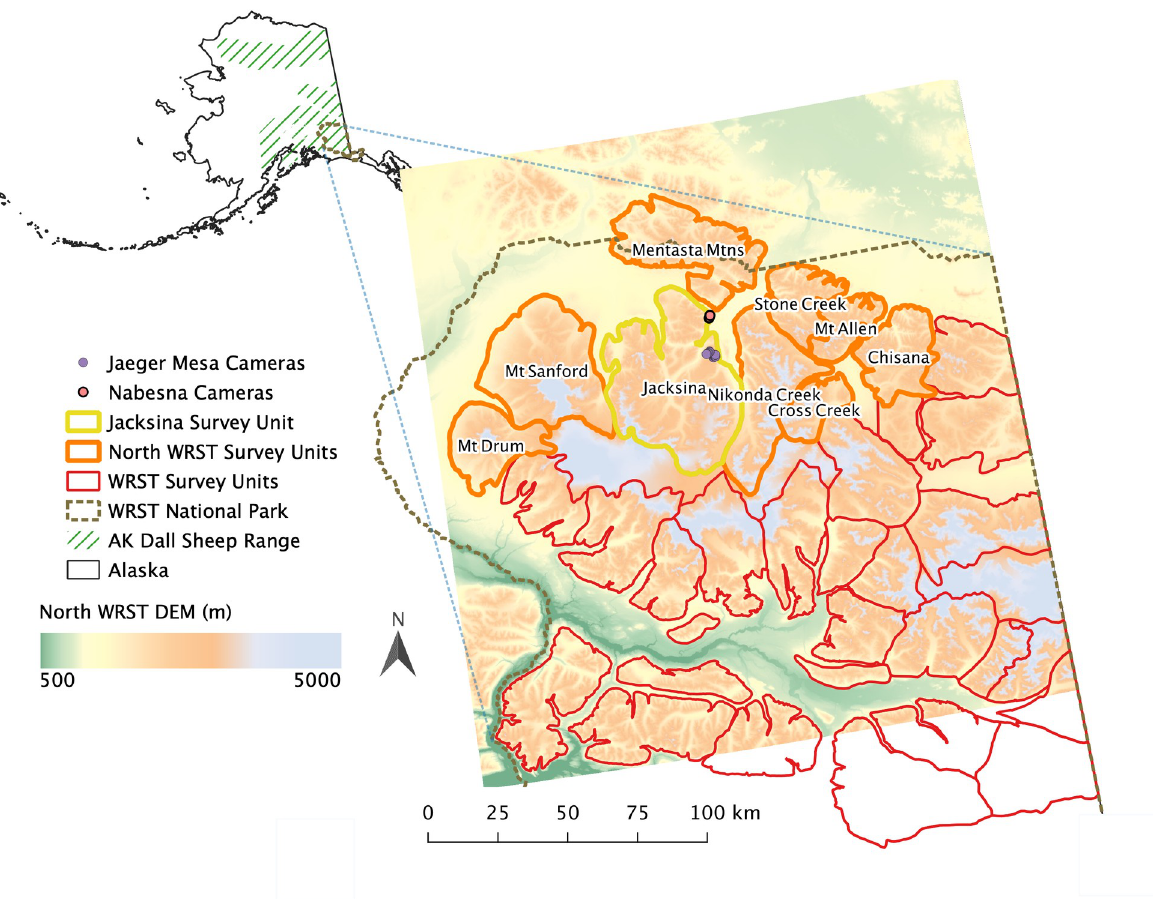
Fig 1. Map of study area located in the northern Wrangell-St. Elias National Park and Preserve (WRST; brown dashed outline) and Alaska (inset). Field-based snow surveys, including the installation of remote cameras upon Jaeger Mesa and near Nabesna, took place in the central Jacksina sheep survey unit (yellow outline) to calibrate a physically-based, spatially distributed snow evolution model. With the calibrated model we simulated daily snow conditions for high-elevation Dall’s sheep terrain within the Jacksina survey unit domain from 1980 to 2017. A remote sensing analysis determined that the mean snow disappearance date (SDD) in 8 other survey units (outlined orange) was more similar to that of Jacksina compared to that of other units in the WRST (outlined red). We hence used observations of summer lamb-to-ewe ratios from Jacksina and these 8 nearby units to compare to model-derived metrics of seasonal snow conditions. GIS data for sheep survey units and WRST park boundary were sourced from [57, 58] respectively, the background digital elevation model is built from 1 Arc-second Digital Elevation Models (DEMs) of the United States Geological Service National Map 3D Elevation Program